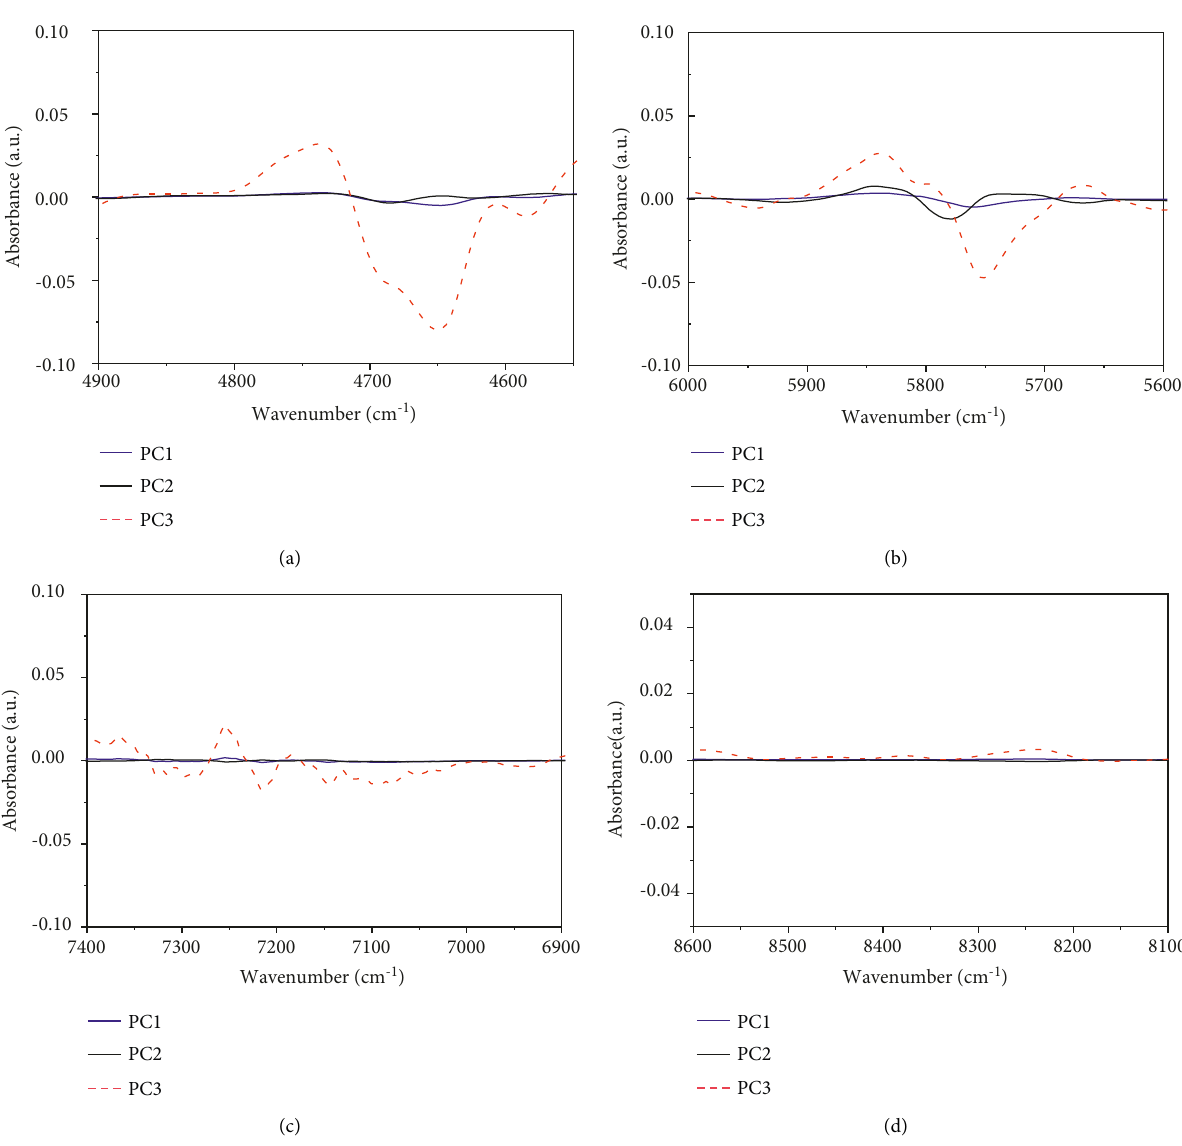
Table 2: Results of external validation of the AFB